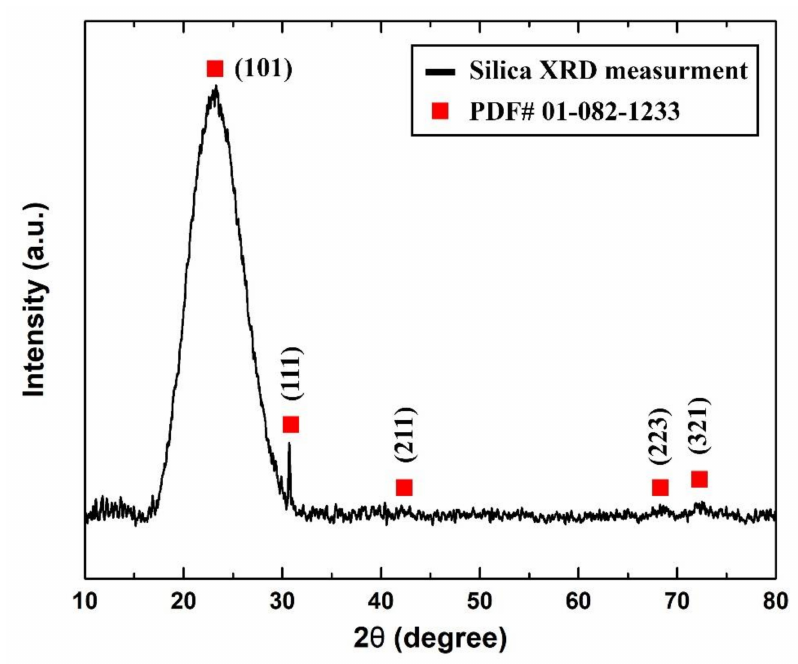
Figure 5. As-received sample measured XRD